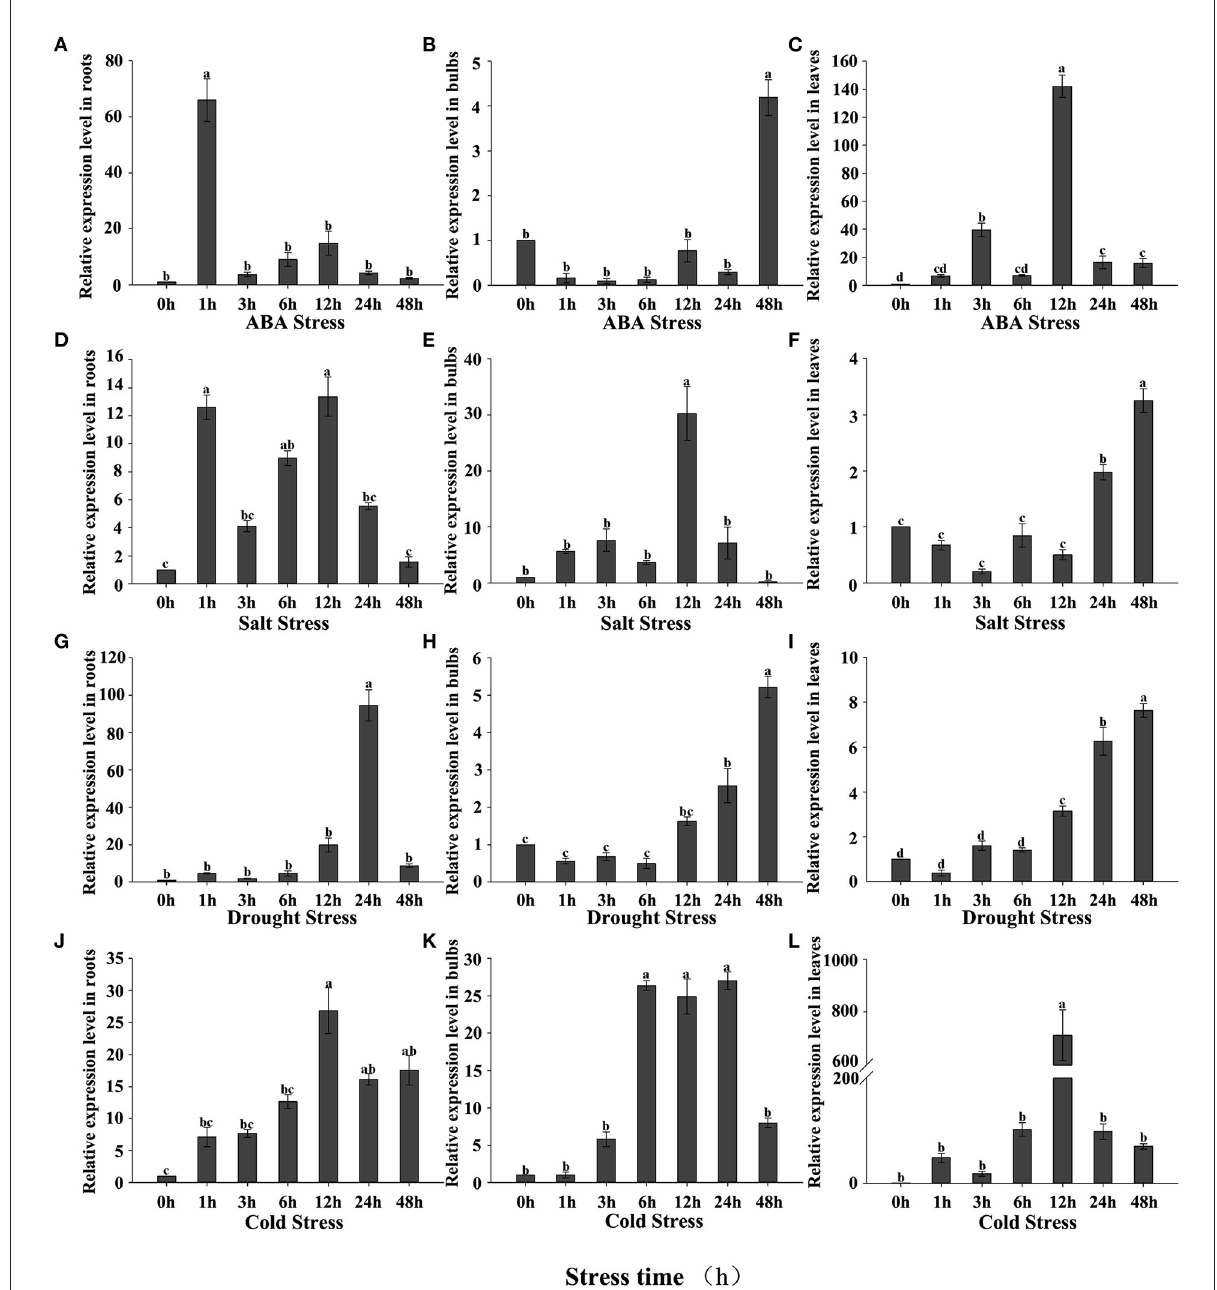
FIGURE2 Expression patterns of LpNAC17 in roots, bulbs, and leaves of L. pumilum under abiotic stress treatment. (A–C) 150 µ M ABA treatment. (D–F) 200mM NaCl treatment. (G–I) 20% PEG-6000 treatment. (J–L) 2 ◦ C treatment. Bars represent the SE of three independent experiments and the different letters indicate the significant difference at P <